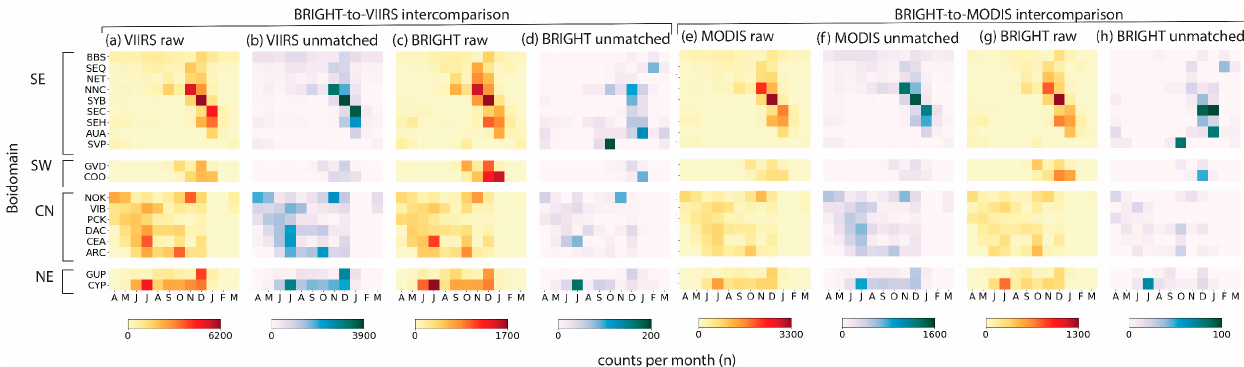
Figure 7. Daytime counts per month per biodomain. Shown are biodomains that contain either 50% of the raw fire activity or 50% of the unmatched fire activity; in southeast (SE), southwest (SW), central-north (CN), and northeast (NE) groupings. Note the different ranges on the color-bars. Raw and unmatched counts are shown for the BRIGHT-to-VIIRS and BRIGHT-to-MODIS intercomparisons, labels as marked. For a description and the location of each bidomain, see Figure 6.